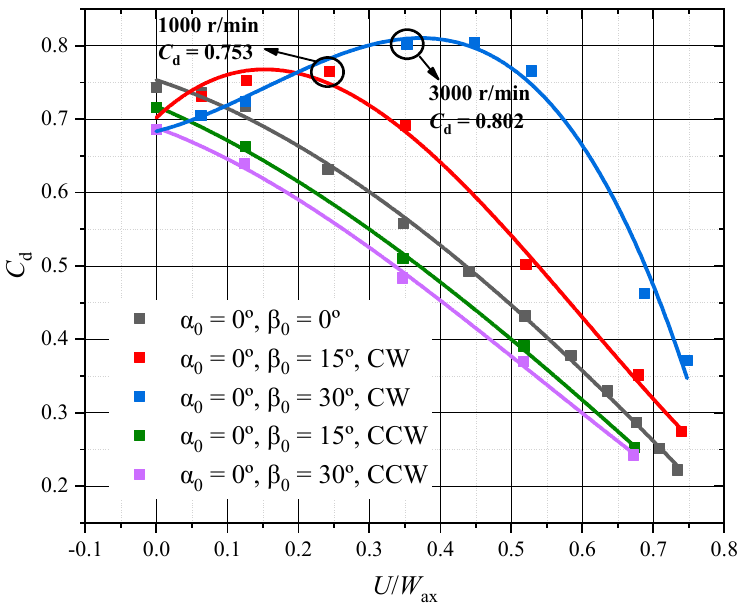
Figure 14. Variation in C d with U/W ax under different circumferential inclination angles (0 ◦ , 15 ◦ , and 30 ◦ ). In the relative coordinate system, a circumferential deflection of the flow direction is caused by the rotation, and the flow direction after deflection may be further away from the orifice axis or closer to the orifice axis, depending on the magnitude and orientation of rotational speed. As shown in Figure 15, counterclockwise rotation (CCW) and clockwise rotation (CW) produce significantly different incidence angles for the same rotational speed, which explains the variable trends of the characteristic curves and the unfixed position of the maximum value in Figure 14.